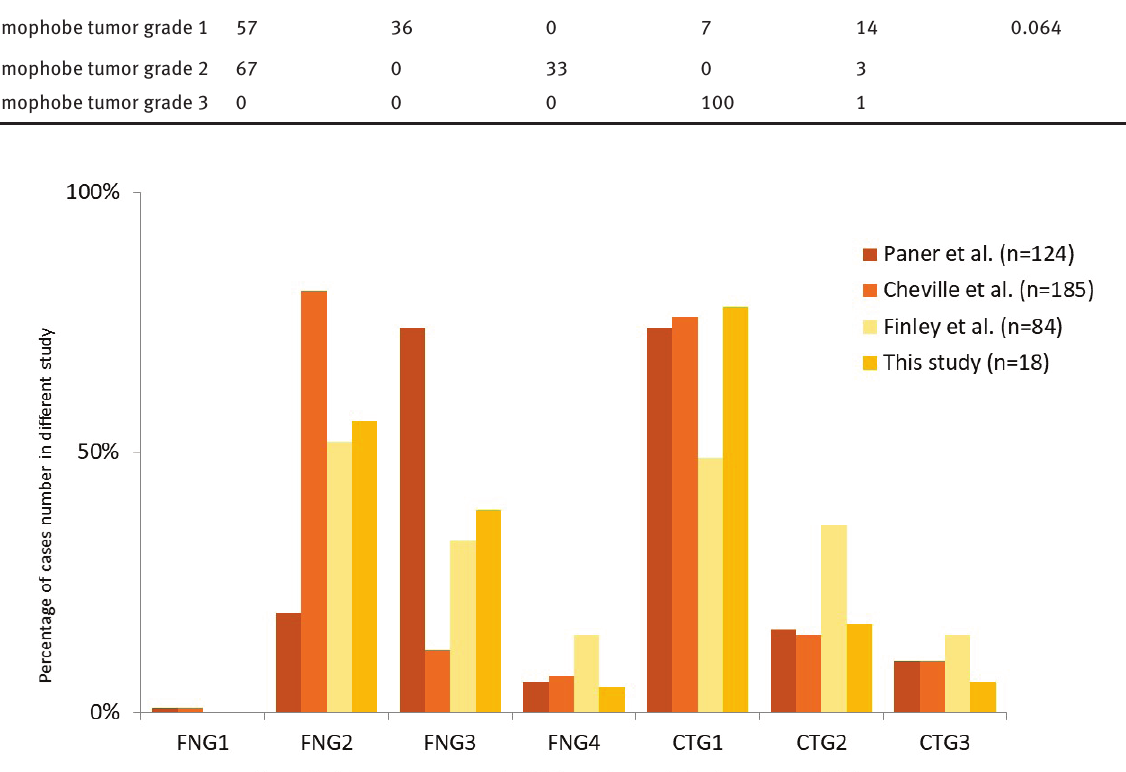
Figure 4: Comparison of FNG and CTG distributions in different studies Only two studies had 1% cases classified as FNG 1. Most cases were classified as FNG 2 or 3 and were classified as CTG